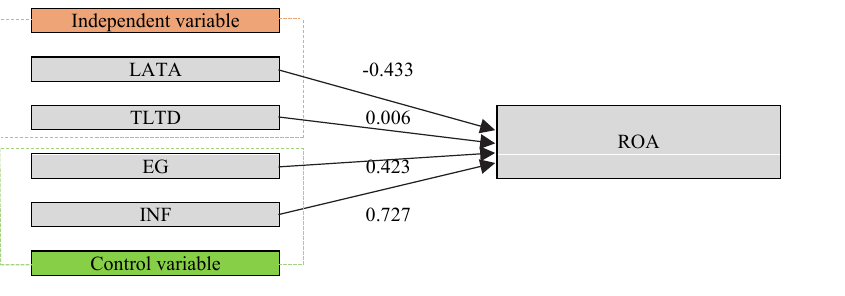
Fig 2. Results of the coefficient estimation